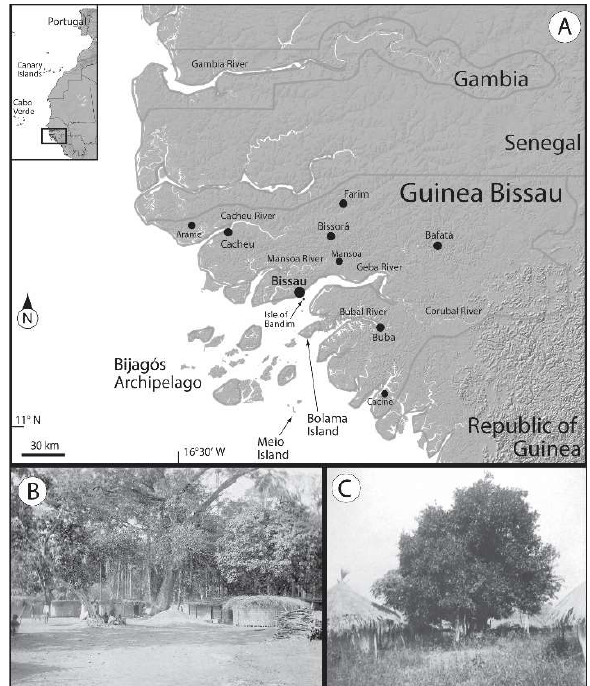
Figure 1. ( A ) West Africa with details of the modern-day boundaries of Guinea-Bissau, which were only established in 1886, following the treaty between France and Portugal. Localities indicated on the map were the focus of the first botanical expeditions, which mainly centered on insular and coastal areas. ( B ) Bafatá region: camp in Irancunda (Canadú); ( C ) Bijagós archipelago (Agô Grande).